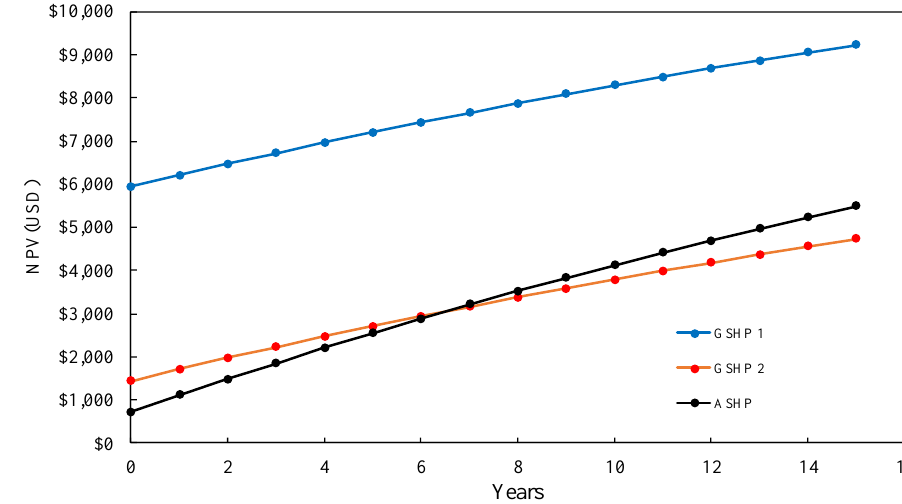
Figure 20. NPV of the heat pumps assuming the GSHP uses 40% less power than the ASHP.